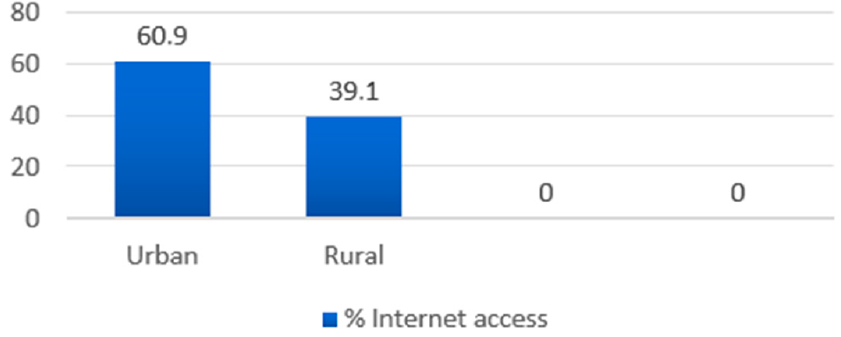
Figure 9. Households equipped with a computer at home, by the sources of origin (2020).